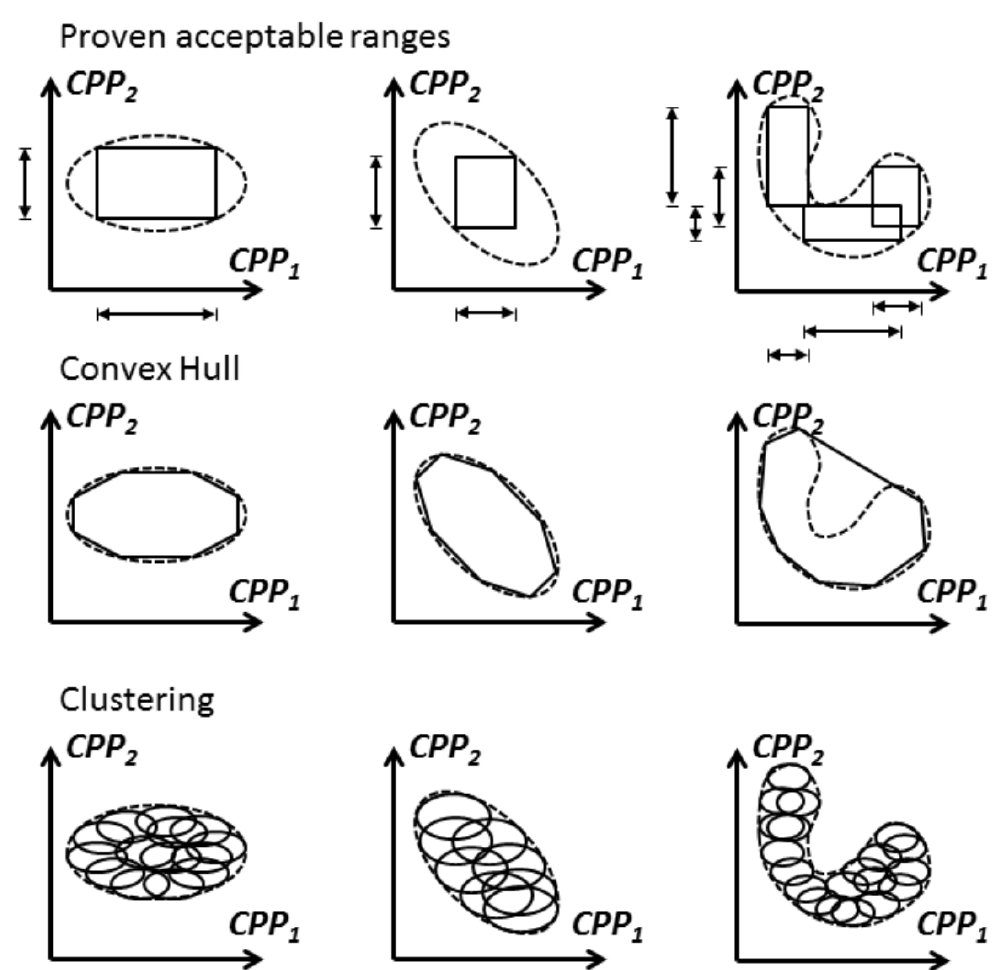
Figure 1. Three stand-alone ways of representing the design space. Dashed line: Explored design space; Continuous line: Design space boundaries described by the chosen representation